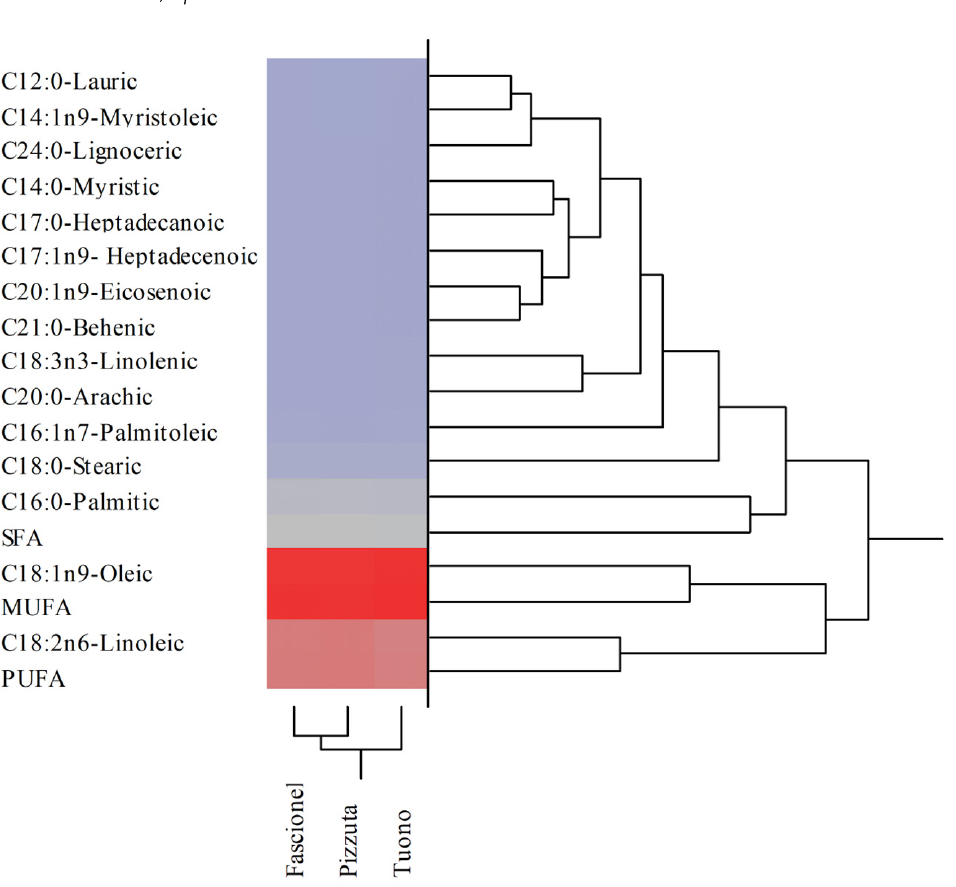
Figure 2. Agglomerative two-way hierarchical clustering analyses of the fatty acid profiles of blanched skin (BS) belonging to Fascionello, Pizzuta, and Tuono cultivars.